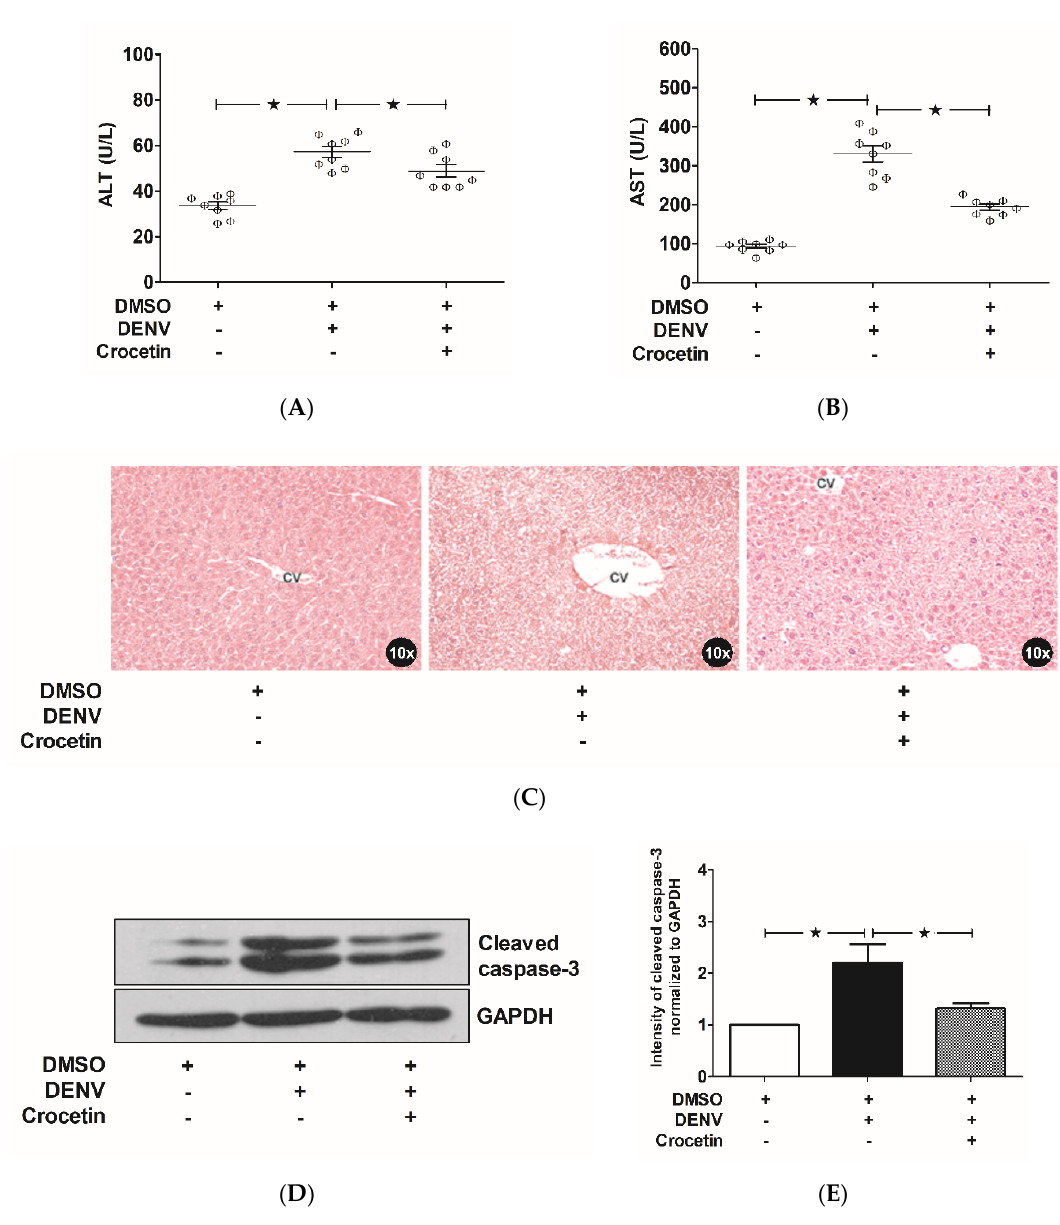
Figure 3. Crocetin reduced liver injury in DENV-infected mice. BALB/c mice were infected with DENV-2 (4 × 10 5 FFU/mL) and then treated with crocetin (50 mg/kg) dissolved in 2% DMSO. DENV-infected 2% DMSO-treated and mock-infected 2% DMSO-treated groups of mice were used as positive and negative controls, respectively. Blood samples were collected on day 7 post-infection, and serum was prepared for the estimation of liver enzymes. Liver tissues were excised after sacrifice on day 7. Histopathologic analysis with H&E staining was then conducted. Western blot analysis was performed on protein samples obtained from liver homogenates, and the blots obtained were quantitated by ImageJ densitometry analysis. The results are shown as follows: ( A ) AST, ( B ) ALT, ( C ) Histopathologic analysis with H&E staining (CV represents the central vein), ( D ) Western blot analysis of cleaved caspase-3 expression, and ( E ) Densitometry of cleaved caspase-3 expression. The black star represents, those groups were compared and found to be significant.